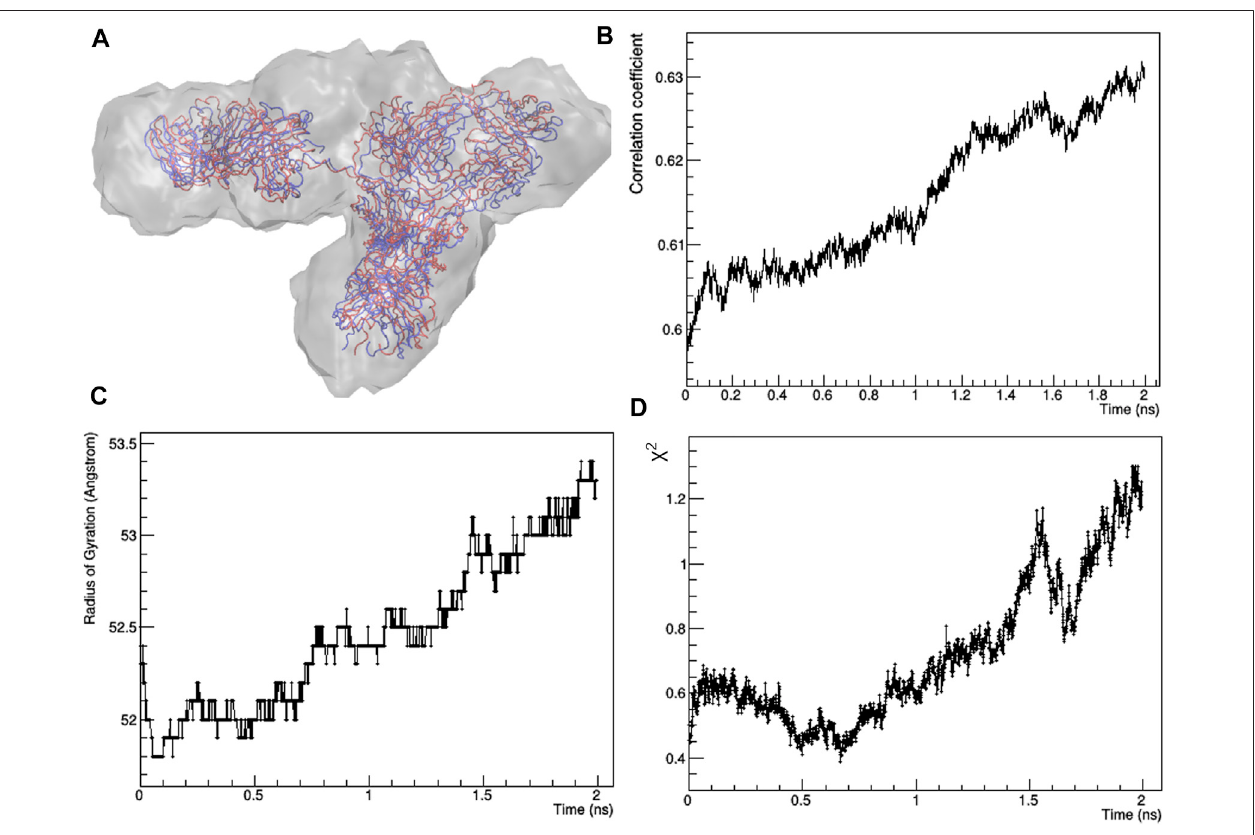
FIGURE3| Results oftherestrainedmoleculardynamicscarried outbyusingtheMDFFprotocol: (A) starting(red)and fi nal(blue)structuralmodelssuperposedto the experimental molecular envelope; (B) Pearson ’ s correlation factor between calculated and observed molecular envelopes; (C) radius of gyration as a function of the simulation time; (D) χ 2 value of the fi t between calculated and observed SAXS pro fi le as a function of the simulation time.